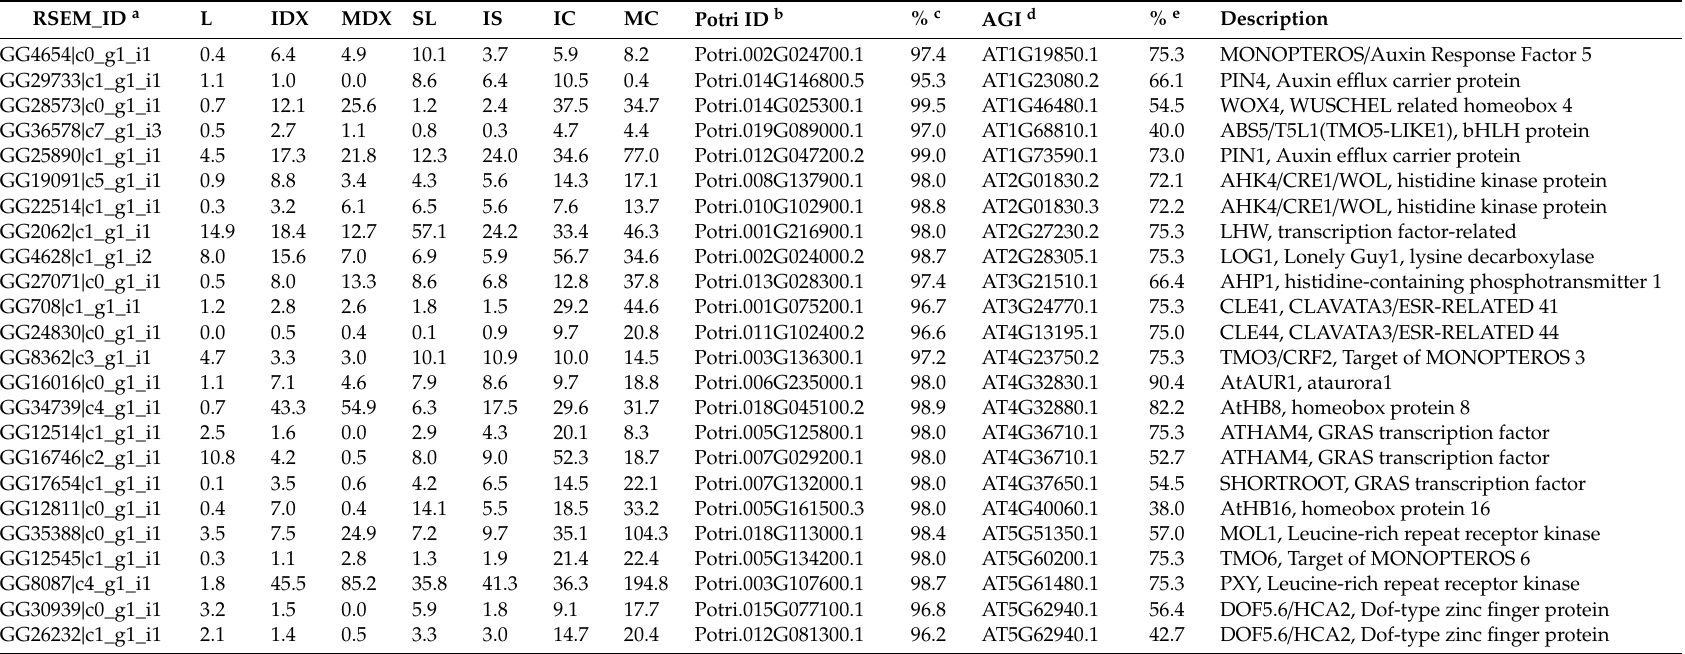
Table 1. Expression of genes involved in the cambium initiation and